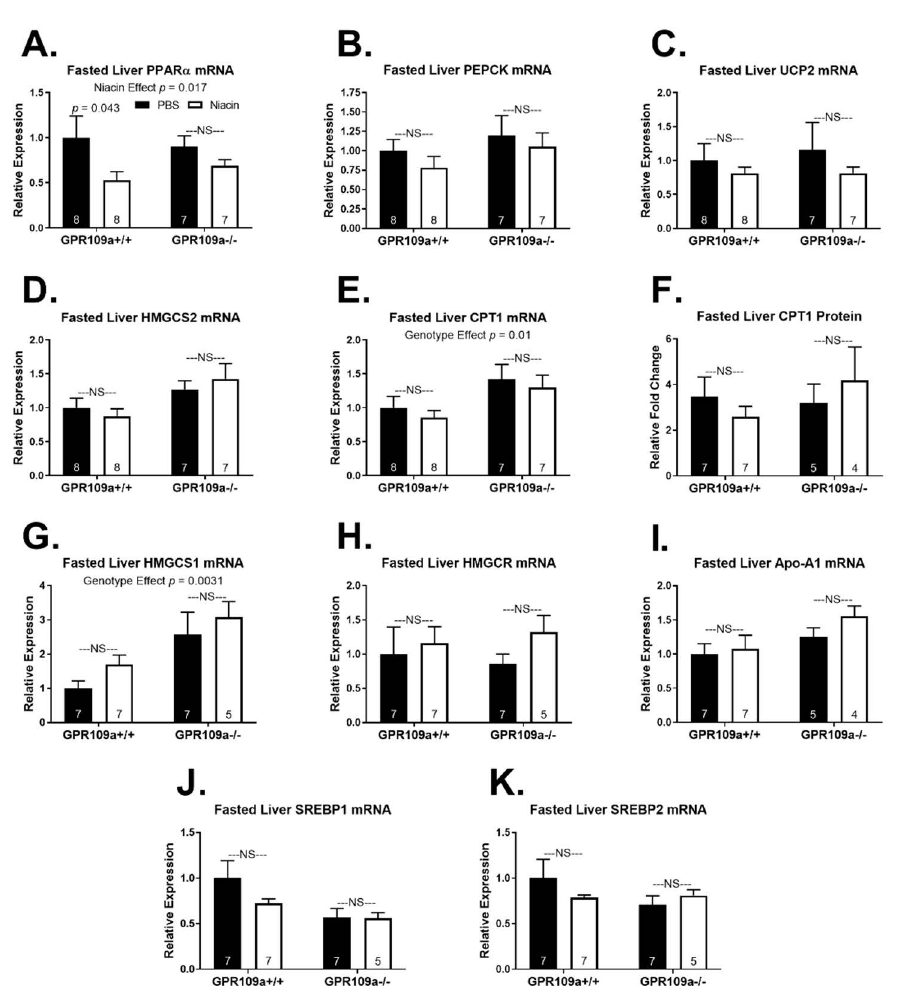
Figure 6. Effect of niacin on hepatic gene expression in 16 h fasted GPR109a +/+ and − / − mice. Hepatic ( A ) PPAR α mRNA expression, ( B ) PEPCK mRNA expression, ( C ) UCP2 mRNA expression, ( D ) HMGCS2 mRNA expression, and ( E ) CPT1 mRNA expression, ( F ) CPT1 protein expression, ( G ) HMGCS1 mRNA expression, ( H ) HMGCR mRNA expression, ( I ) Apo-A1 mRNA expression, ( J ) SREBP1 mRNA expression, and ( K ) SREBP2 mRNA expression. Direct comparisons were